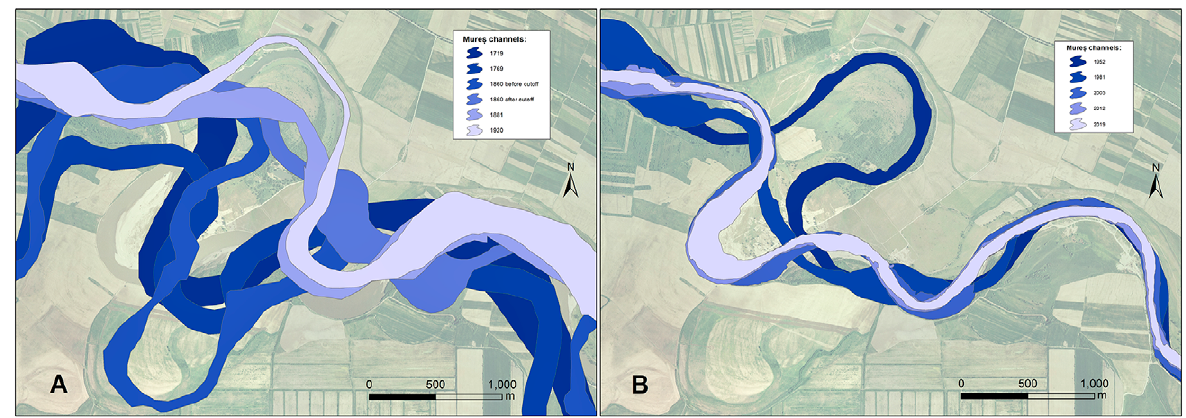
Figure 10. The meander near Sâmbăteni in two periods: 1719-1920 (A) and 1952-2019